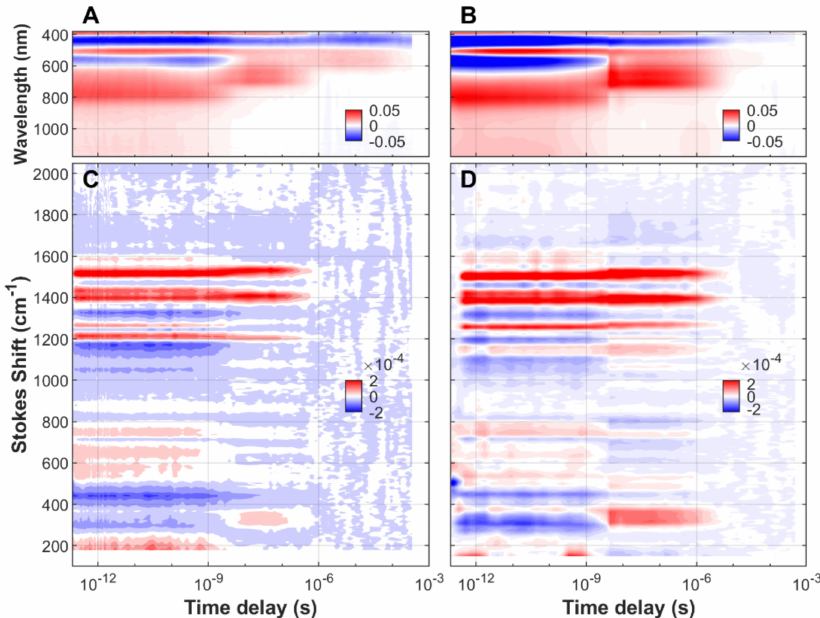
Figure 1. Time-resolved sup-picosecond to sub-millisecond Raman/absorption spectra of free FMN upon excitation with a 475 nm actinic pump. ( A ) TA spectroscopy in H 2 O-based buffer. ( B ) TA spectroscopy in D 2 O-based buffer. ( C ) Transient FSRS in H 2 O-based buffer. ( D ) Transient FSRS in D 2 O-based buffer. The buffer was MES 50 mM NaCl 100 mM at pH (or pD) = 6.8. The Raman pump was set to 800 nm. The red color indicates a positive change of Raman intensity (FSRS contour plots) or a positive absorbance change (TA contour plots). On the contrary, the blue color code indicates a negative change of Raman intensity (FSRS) or a negative absorbance change (TA).